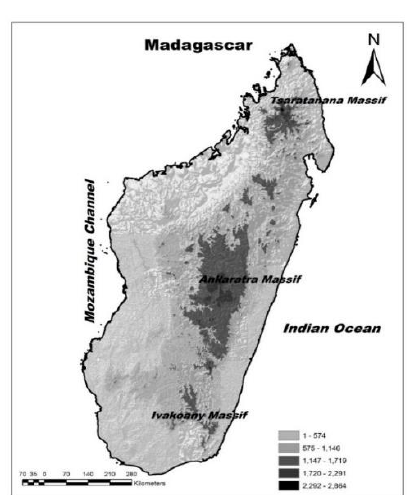
Figure 1. Elevation (m) map of Madagascar prepared